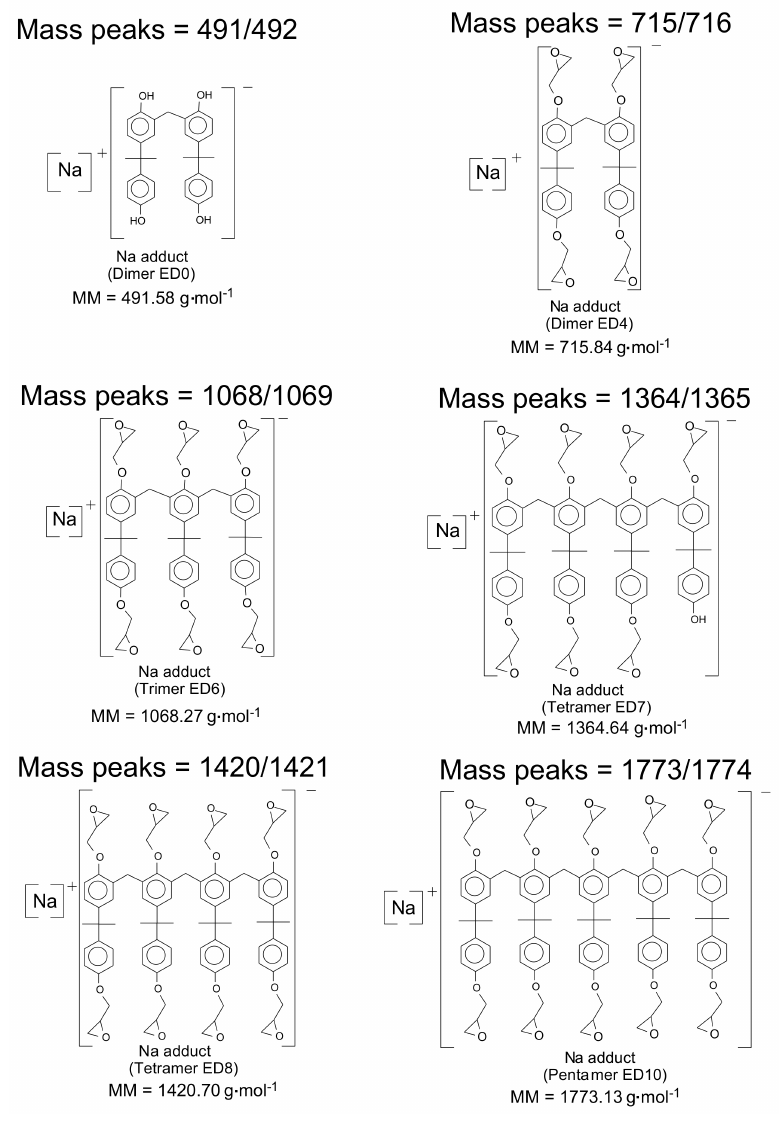
Figure 12. Oligomers structures related to the mass peaks at MALDI-TOF